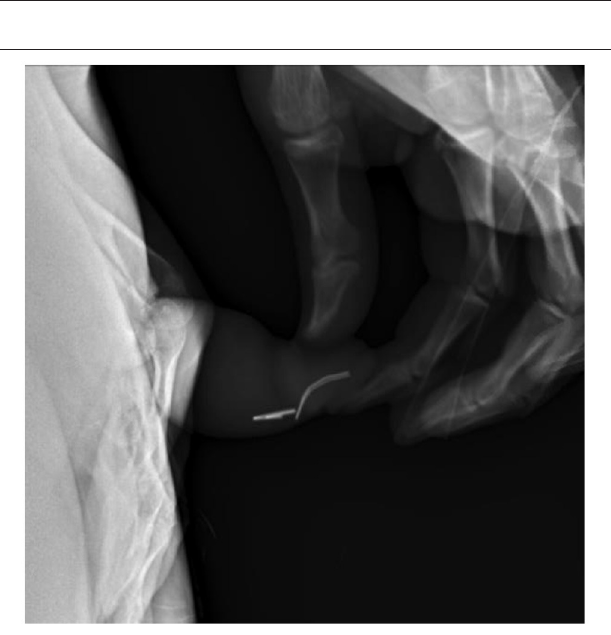
FIGURE 4 | Lateral view pelvic X-ray identifies staples in distal penile urethra, which requires endoscopic removal.